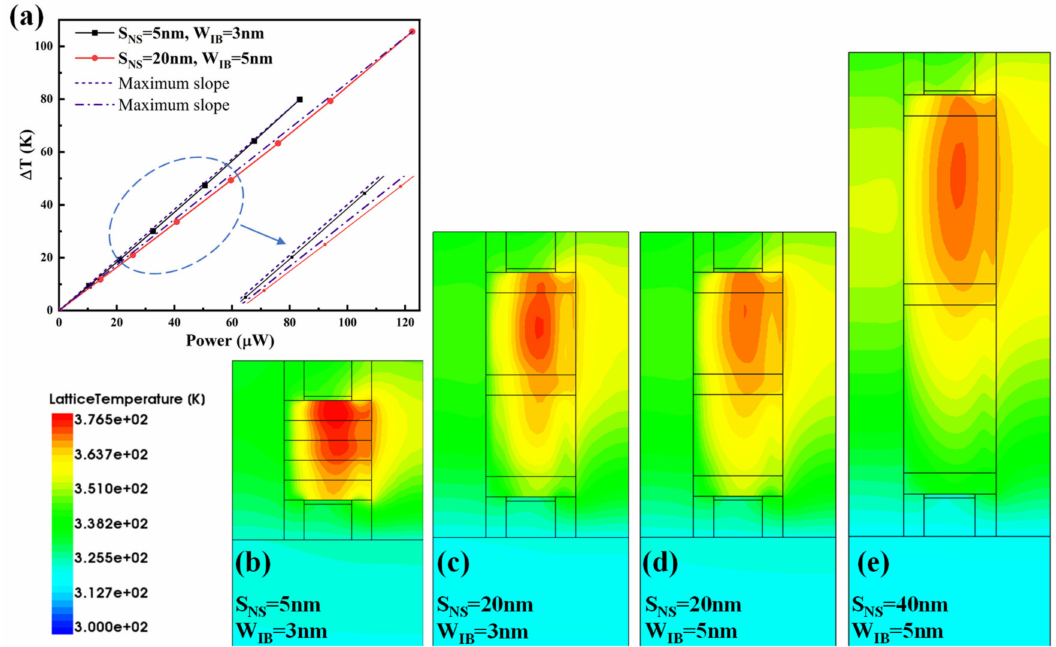
Figure 13. ( a ) DC power- ∆ T curve; thermal distribution of TreeFETs at 80 µ W with ( b ) S NS = 5 nm, W IB = 3 nm; ( c ) S NS = 20 nm, W IB = 3 nm; ( d ) S NS = 20 nm, W IB = 5 nm; ( e ) S NS = 40 nm, W IB = 5